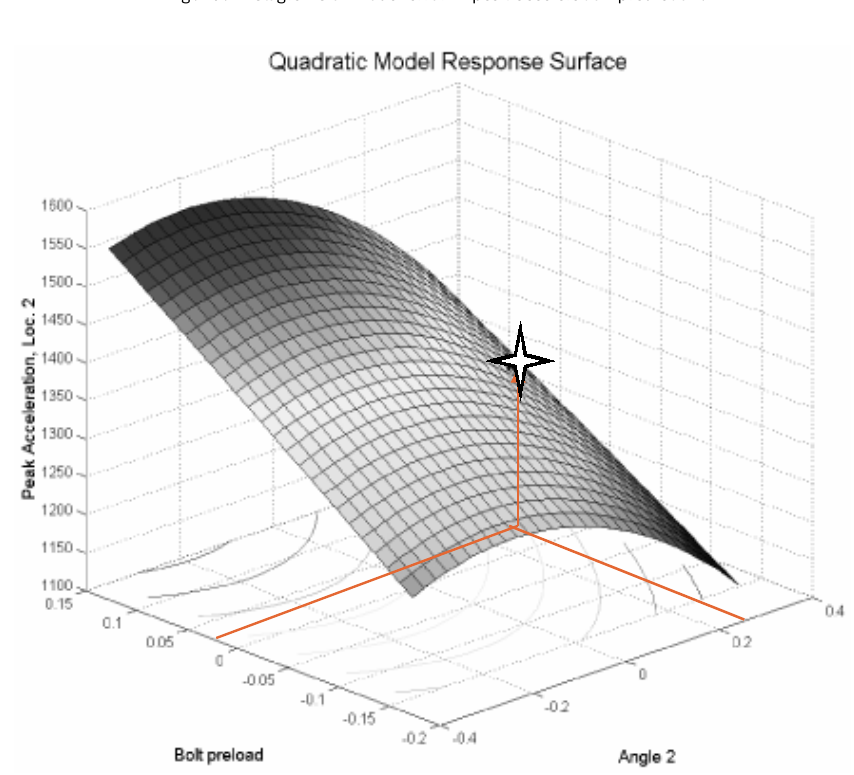
Fig. 11. Response surface of the